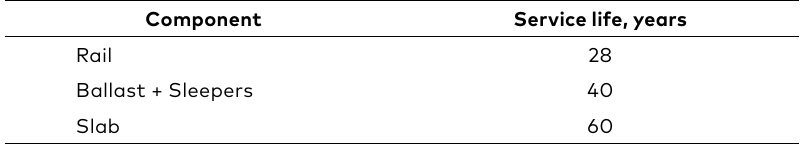
Table 2. The service life of track